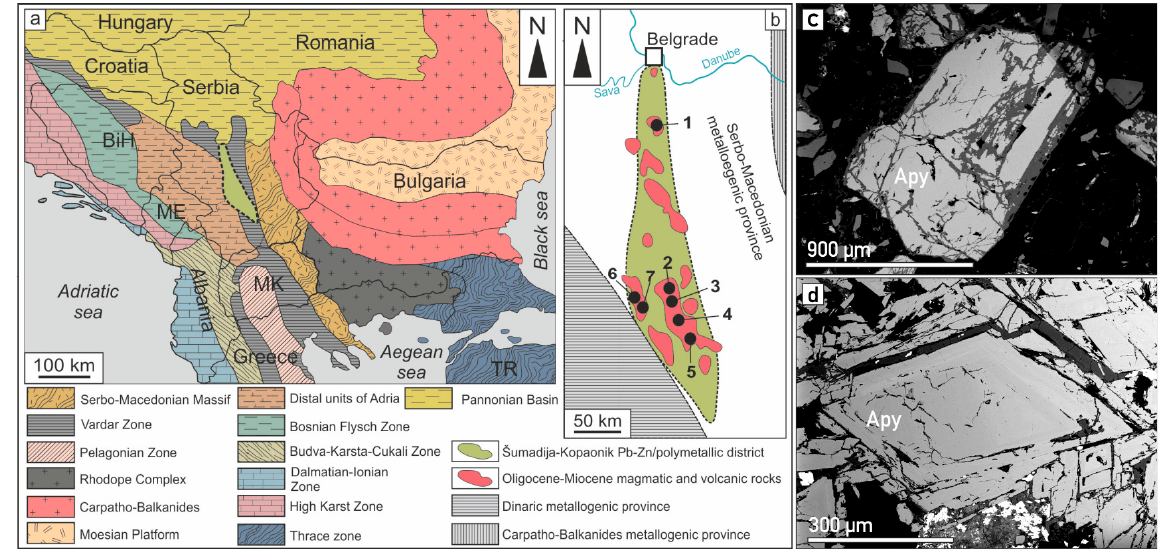
Figure 1. ( a ) Geologic structure map of Balkan Peninsula; detailed descriptions can be found in [15], regional geologic map after [16]. ( b ) Simplified schematic map of the Šumadija-Kopaonik Pb-Zn/polymetallic ore district with sampling locations: 1—Rudnik (Pb-Zn-Cu-(Ag) mine), 2—Rujak (Apy-Py veins), 3—Drenjak (Au mineralisation in Apy vein), 4—Sastavci (Pb-Zn mine), 5—Trepˇca (Pb-Zn mine), 6—Golijska reka (W-Mo-Bi mineralisation), 7—Jurija (W mineralisation). ( c , d ) SEM-BSE micrographs of characteristic arsenopyrite samples from ( c ) Drenjak and ( d ) Sastavci locations, the latter showing visible zoning due to non-homogenous chemical